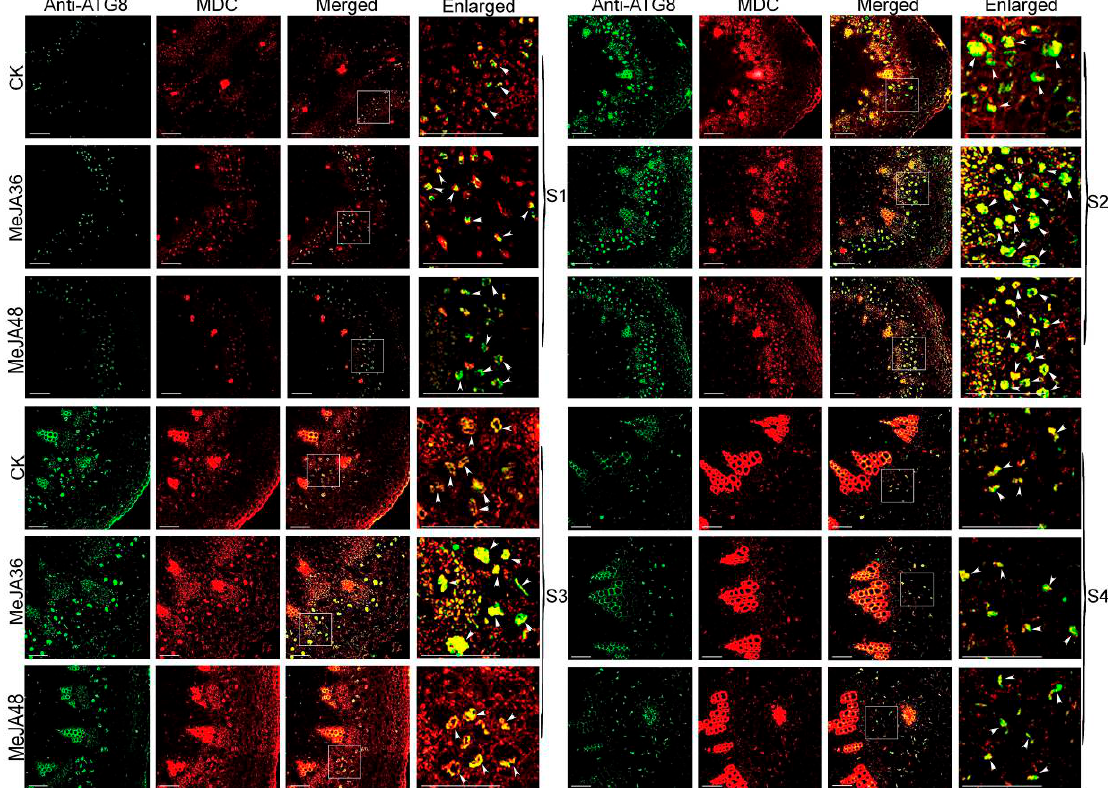
Figure 6. Autophagy activation monitoring by colocalization analysis of anti-ATG8 antibody-Alexa Fluor 488 and monodansylcadaverine (MDC) in laticifers of Euphorbia kansui . S1: the differentiation stage of the primary meristem of stems. S2, S3: the developing stage of the primary structure of stems. S4: the developing stage of the secondary structure of stems. Laticifers were depicted with white arrows. Bars = 100 nm.